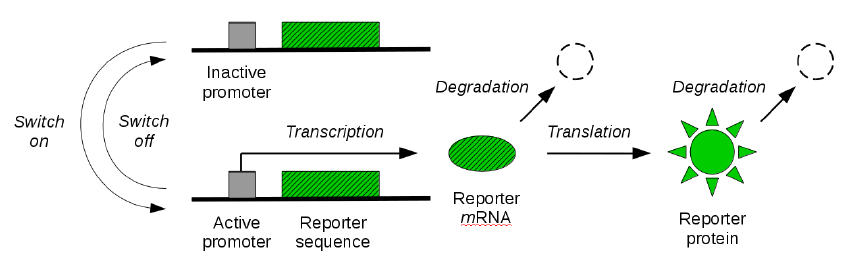
Figure 1. Reporter gene system. The coding sequence of a fluorescent reporter protein is engineered into a gene of interest. The gene promoter can switch between an inactive (off) and an active (on) state. When active, transcription of reporter m RNA molecules is enabled. Existing m RNA molecules are further translated into visible (quantifiable) reporter protein molecules. Both m RNA and protein molecules are subject to